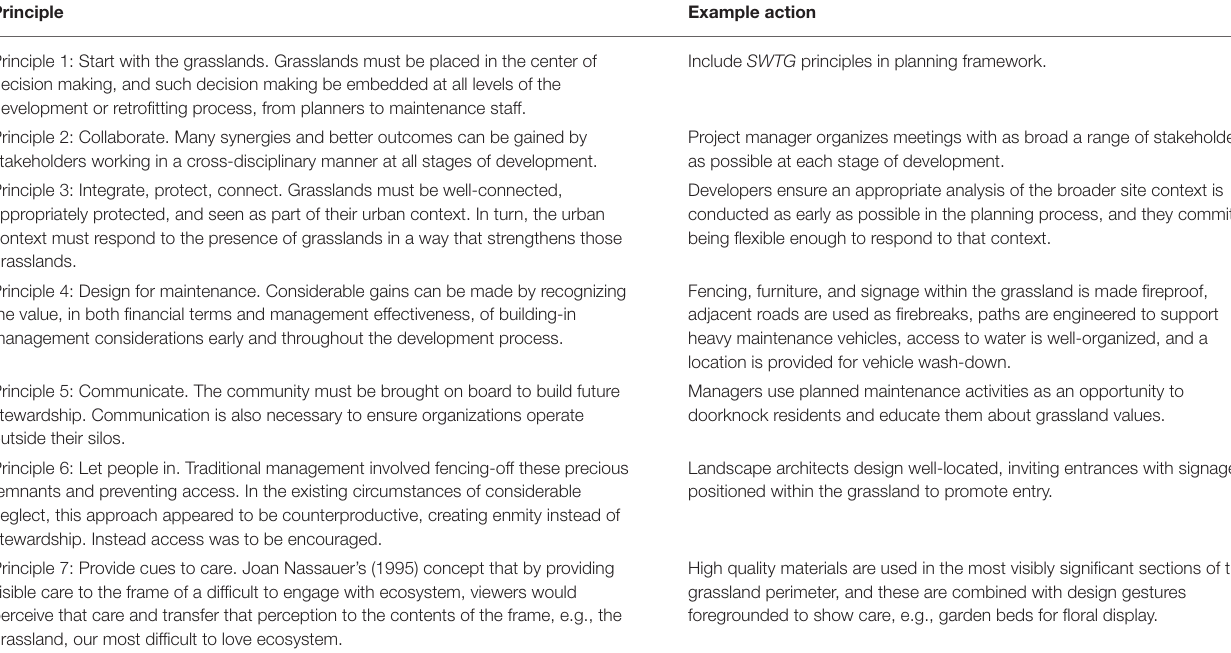
TABLE 2 | Principles and example actions to promote the biophilic design of grassland contexts. Principle Example